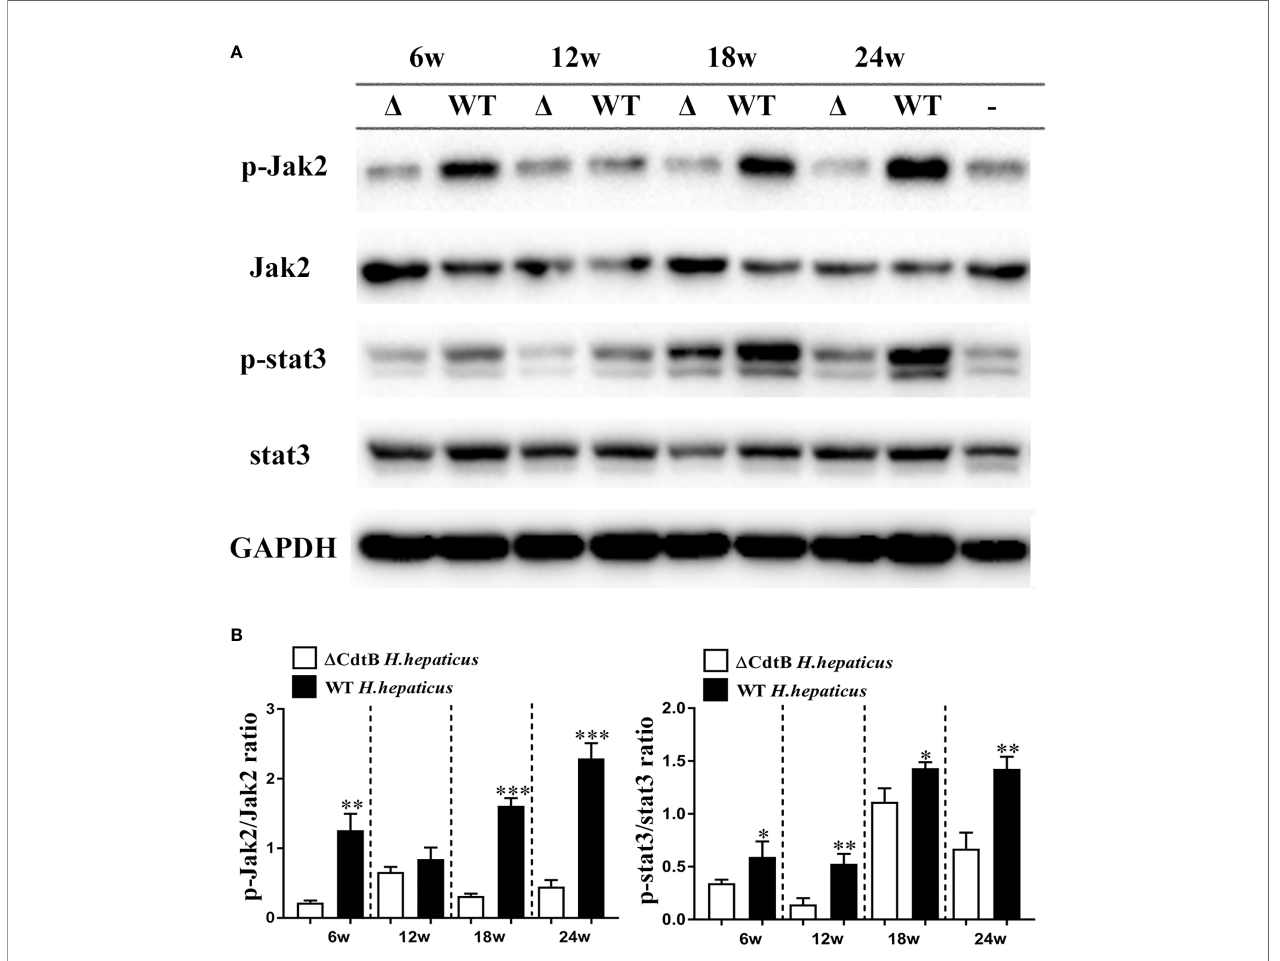
FIGURE 7 | H. hepaticus promoted activation of Jak2 and Stat3 . (A) Western blotting and densitometric analysis of p- Jak2 , Jak2 , p- Stat3 , Stat3 , and GAPDH; WT represents wild type H. hepaticus , D represents D CdtB H. hepaticus , and – represents control sample of 24 WPI. (B) The Statistical data are expressed as the mean SD (n = 5). * P < 0.05 as compared to D CdtB H. hepaticus , ** P < 0.01 as compared to D CdtB H. hepaticus , *** P < 0.001 as compared to D CdtB H.